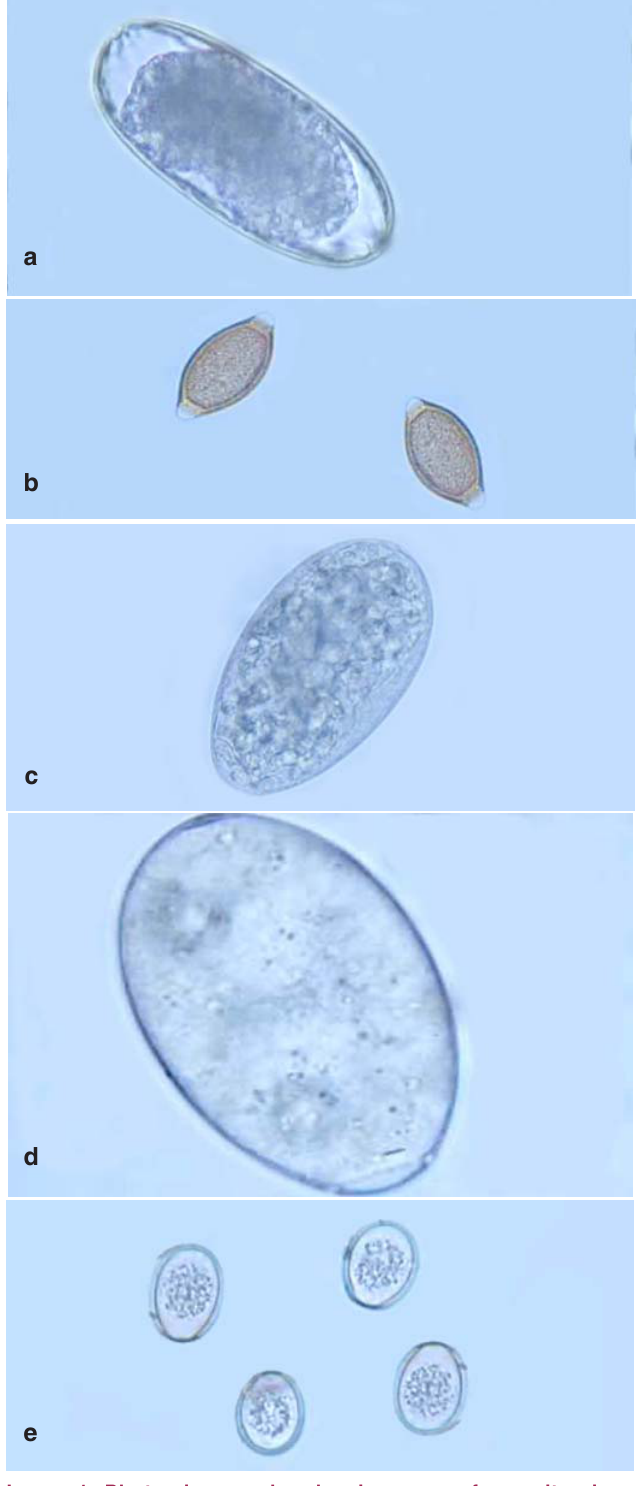
Image 1. Photomicrographs showing eggs of parasites in different